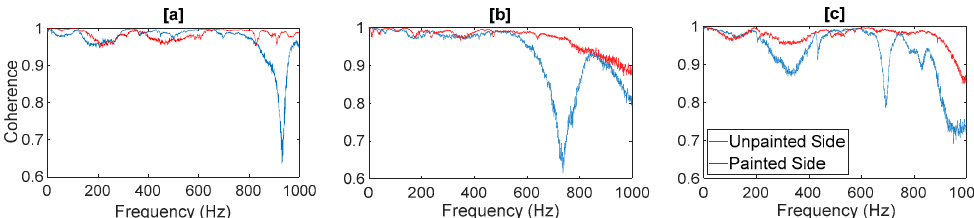
Figure 5. Coherence function of the specimens: ( a ) thin asphalt layer (TAL); ( b ) poroelastic road surface (PERS); ( c ) stone mastic asphalt (SMA).